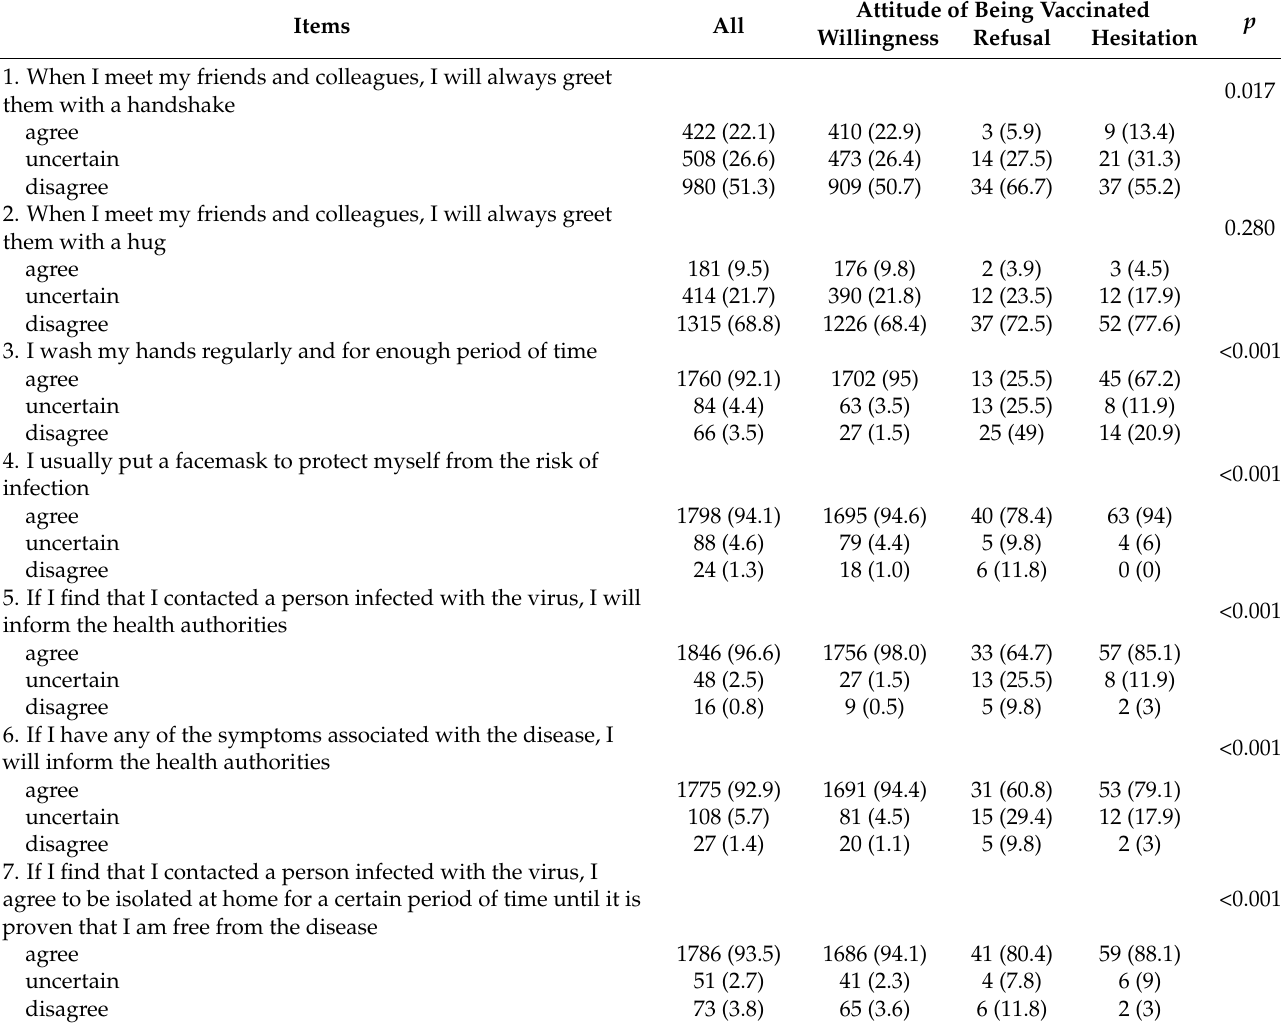
Table 3. The differences between willing, unwilling, and hesitant attitudes in relation to preventive measures of COVID-19. Items All